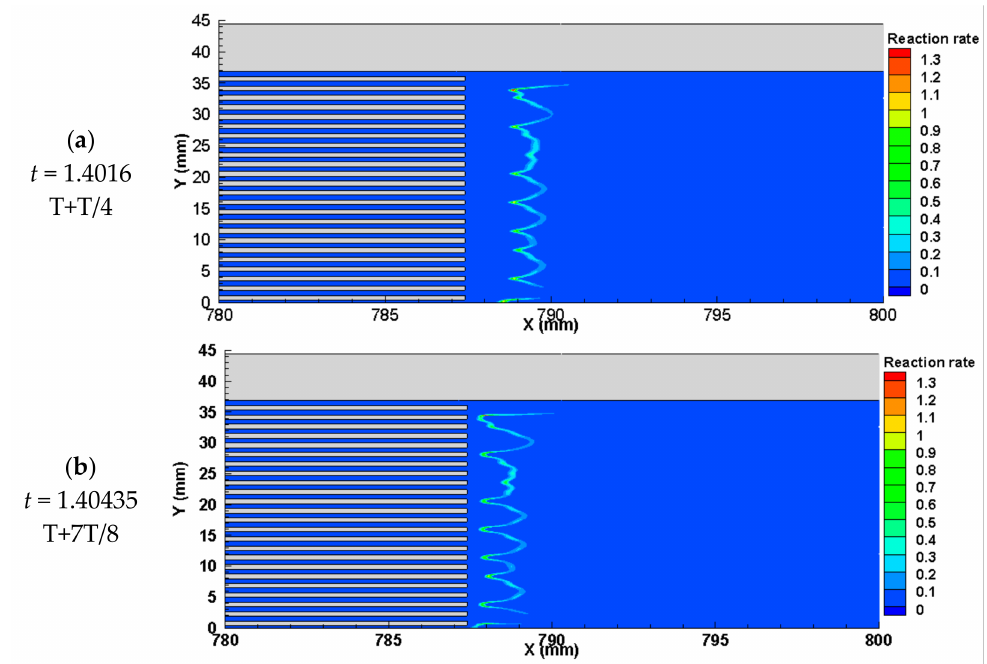
Figure 16. Kinetic rate of reaction at different